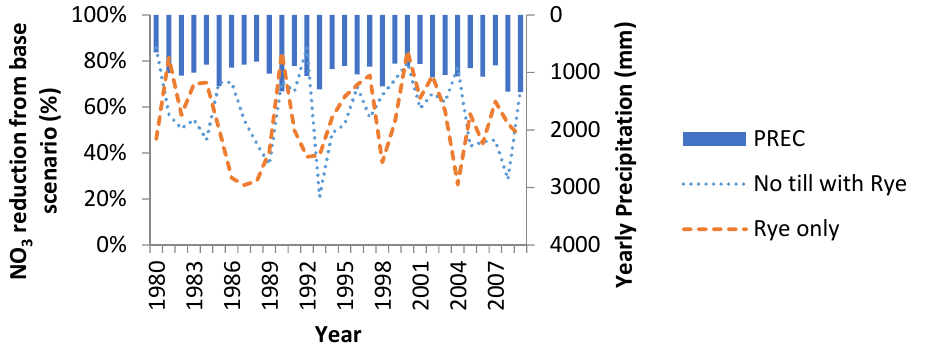
Figure 11. Additional impact on nitrate load reduction of multiple simultaneous BMPs compared with Rye, as seen in Figure 10.